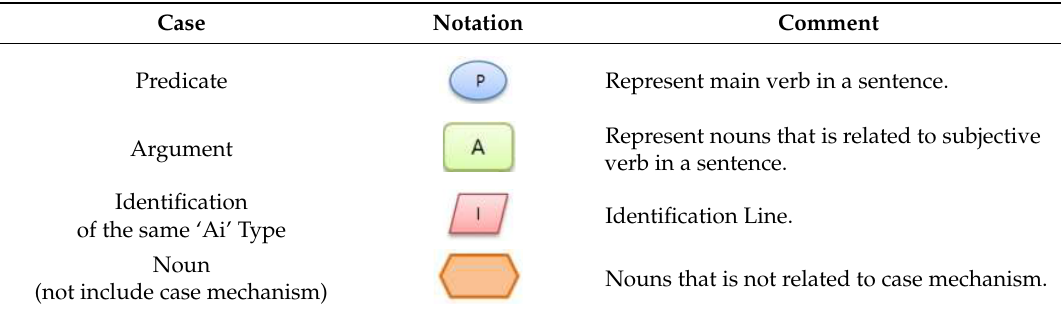
Table 3. Notation of visual modeling [20].